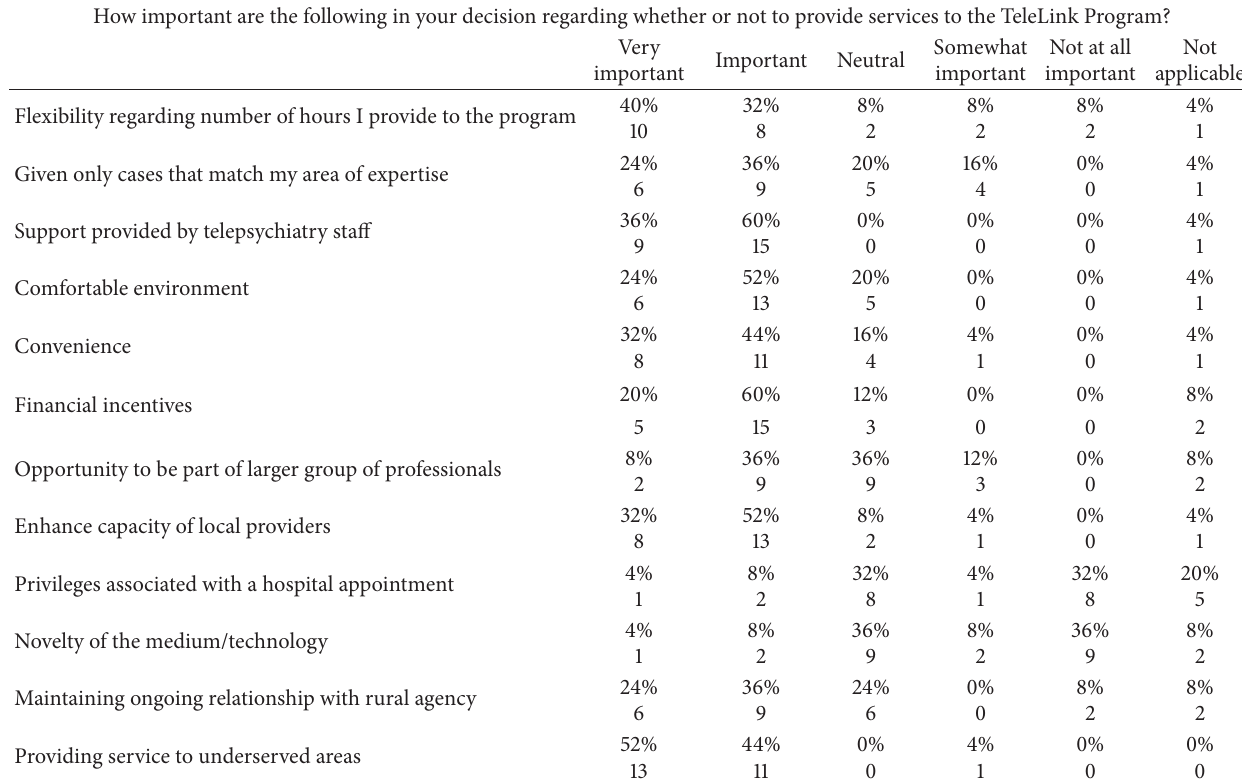
Table 4: Decisions to provide telepsychiatry services-importance rankings ( 𝑛 = 25